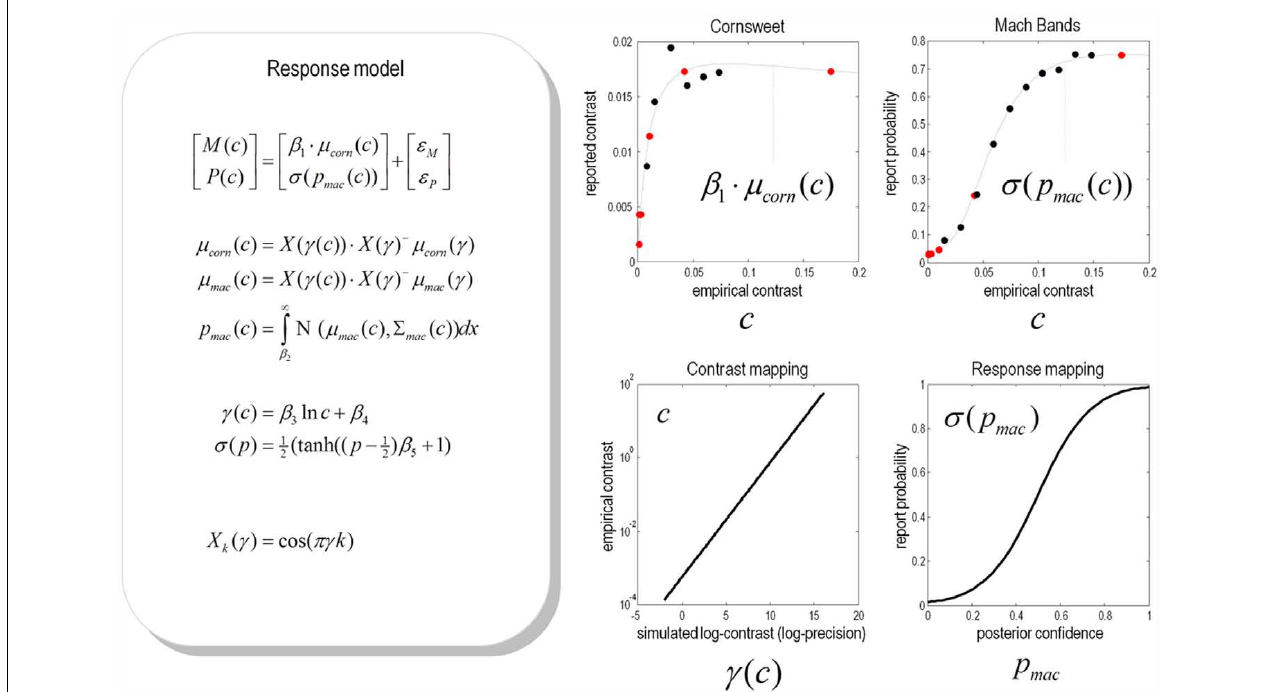
band P ( c ), the coefficients β i can be estimated under the assumption of additive prediction errors ε .The predicted responses following this estimation are shown in the graphs on the right hand side.The upper panels show the empirical data superimposed upon conditional predictions from the model.The gray lines are the predicted psychometric functions, μ corn ( c ) and σ ( p mac ( c )).The red dots correspond to the predictions at levels of contrast used in the simulations (as shown in Figure 9 ), while the black dots correspond to the empirical responses: M ( c ) and P ( c ).The lower left panel show the relationship between the empirical and simulated contrast levels (as a semi-log plot of the empirical contrast against the log-precision of sensory noise).The lower right panel shows the relationship between the probability of reporting a Mach band is present and the underlying conditional probability that it is above